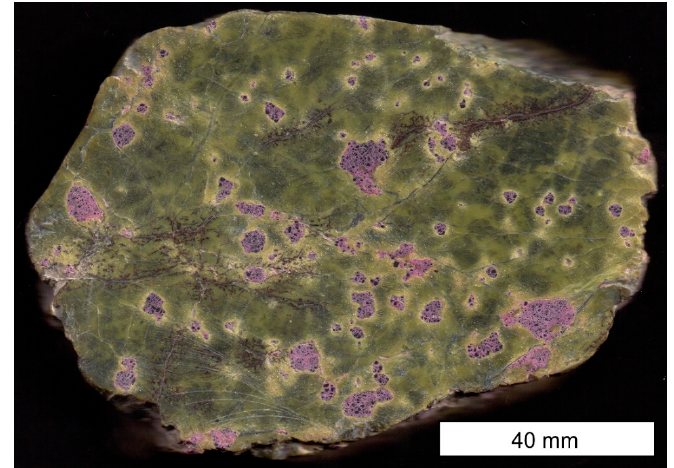
Figure 2. Large representative polished billet of serpentine-hosted stichtite. Slight variations in the shade of green for the serpentine result from slight variations (±4%) in the ratio of lizardite to chrysotile. Black veinlets within the green serpentine are magnetite. The purple stichtite domains contain silvery-black fragments of chromite.